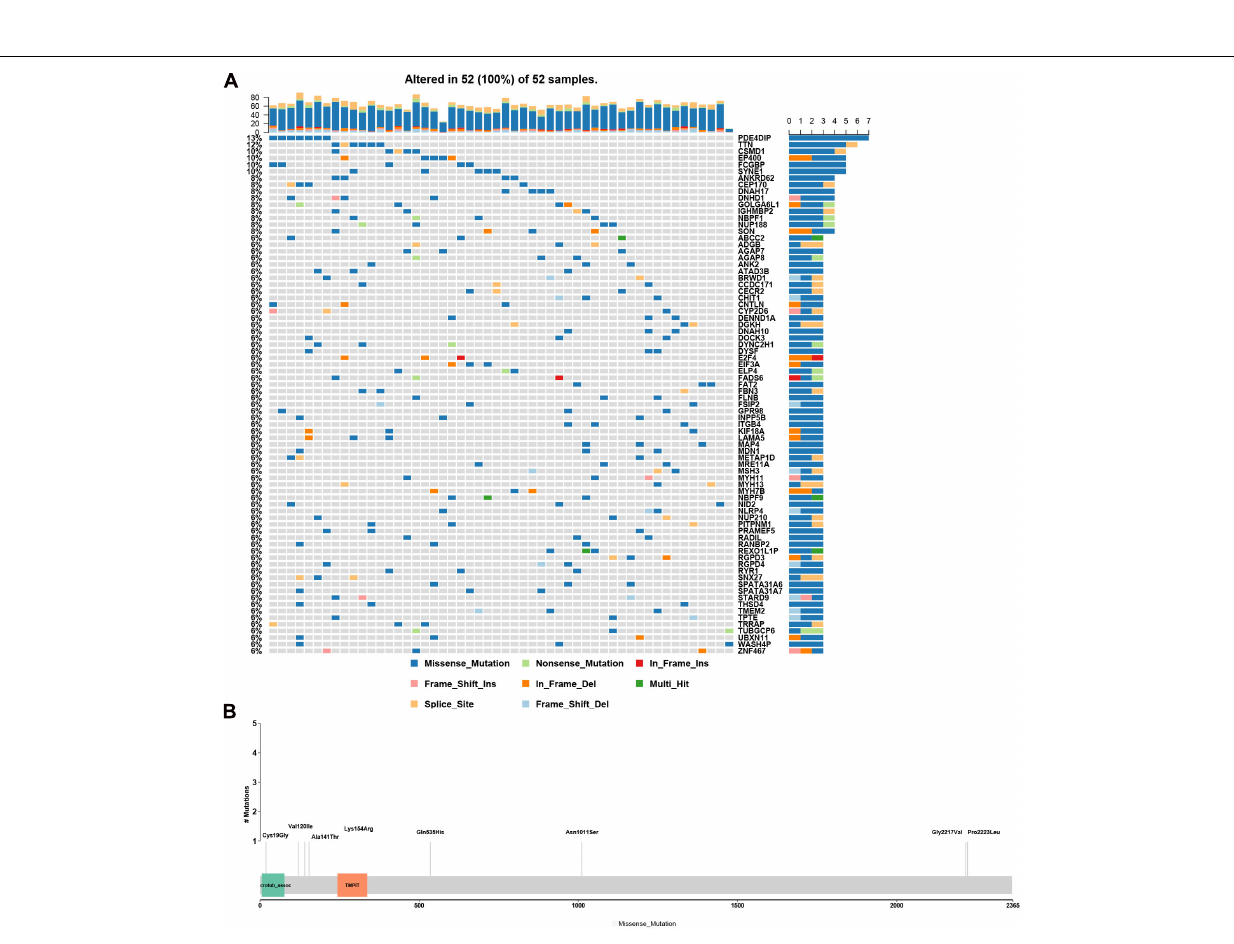
Frontiers in Genetics |